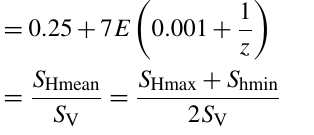
magnitude down to µ < 0 . 1 (Di Toro et al., 2011). Faults are represented by cohesionless contact surfaces in the